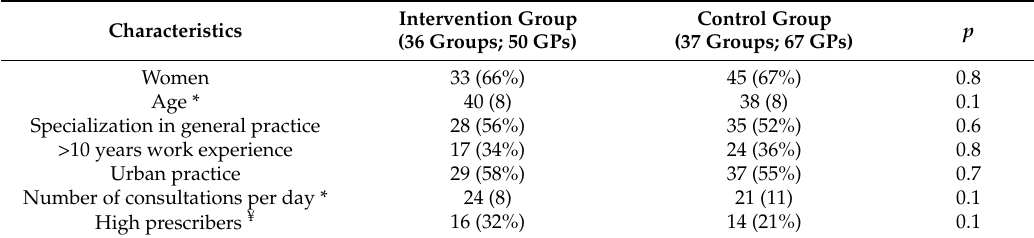
Table 1. Baseline characteristics of participating general practitioners (GPs).